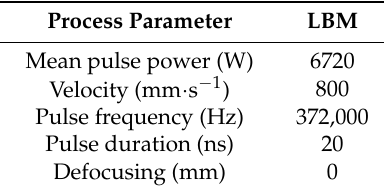
Table 4. LBM parameters for the MetcoClad 718.